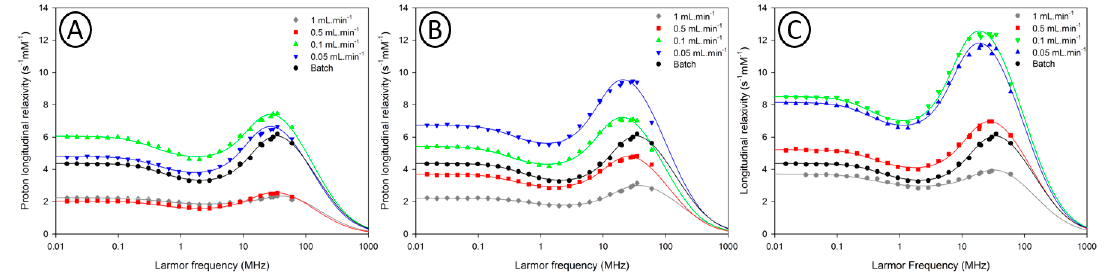
Figure 8. 1 H NMRD profiles of VSION obtained in the 0.5 mm capillary reactor ( A ), the 0.75 mm capillary reactor ( B ) and 1 mm capillary reactor ( C ). The black curve is the NMRD profile of the batch-prepared VSION. The continuous lines correspond to the fitting by the superparamagnetic relaxation theory.